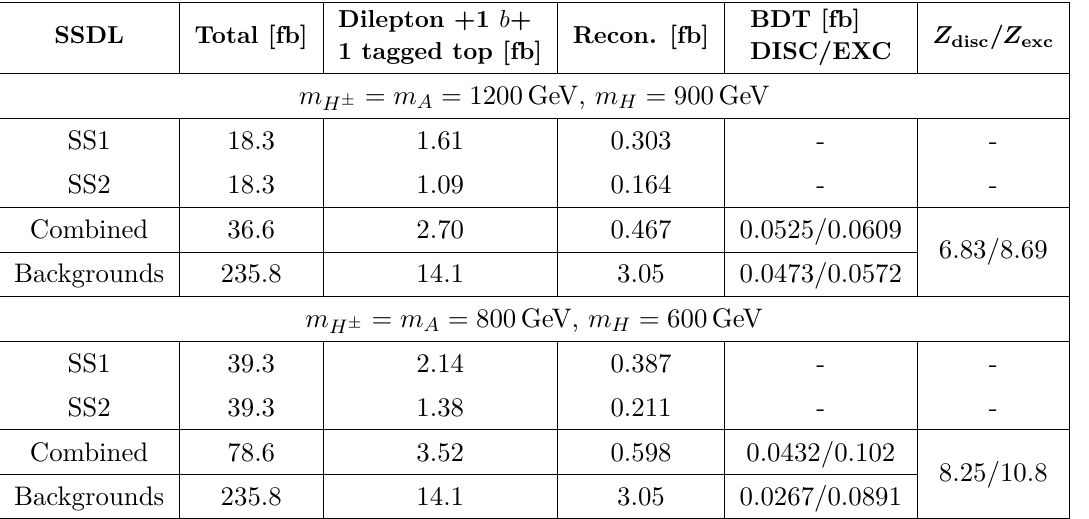
= m A = 800 GeV, m H = 600 GeV (solid) H ±